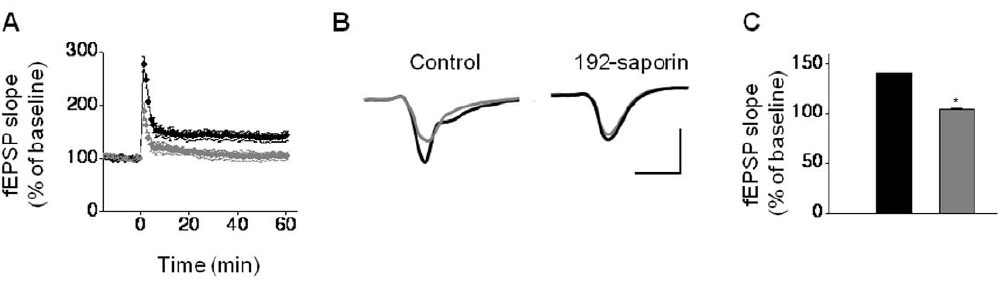
Figure 2. Impairment of LTP in 192-saporin infused rats. (A) Summary data for experiments in which LTP was induced by TBS and measured at 55–60 min after TBS. LTP in 192-saporin infuced rats (gray circles) was reduced compared to the saline infused controls (black circles). (B) Sample traces depicting LTP in saline infused control rats and lack of LTP in 192-saporin infused rats. Traces with gray lines represent those collected prior to TBS, during baseline recording, and the traces with black lines represent those taken 55–60 min after TBS. Calibration: 1 mV, 20 ms. (c) Bar chart showing drastic reduction of LTP in 192-saporin infused rats (gray) compared to the saline infused controls (black).